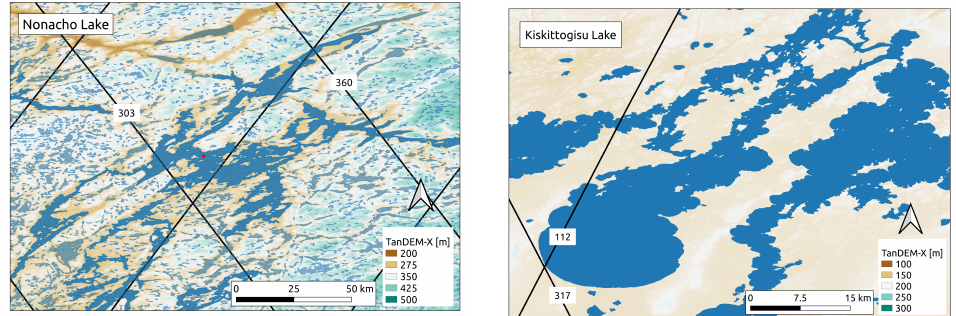
Figure 7. Maps displaying the local topography in the vicinity of Lake Nonacho ( left ) and Lake Kiskittogisu ( right ). The Elevations are WGS84 ellipsoid heights from the TanDEM-X elevation